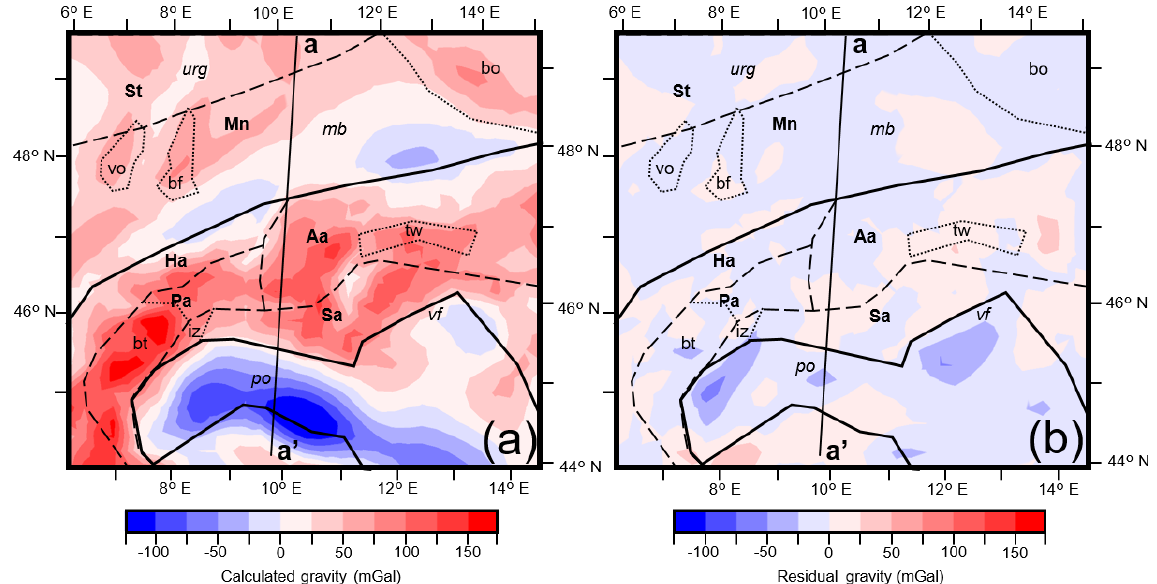
Figure 6. (a) Calculated gravity at 6km above the datum resulting from the final structural and density model. (b) Residual gravity (observed gravity–calculated gravity) of the best-fit model. Locations of key tectonic features are overlaid for both figures (definitions shown in Fig. 1a